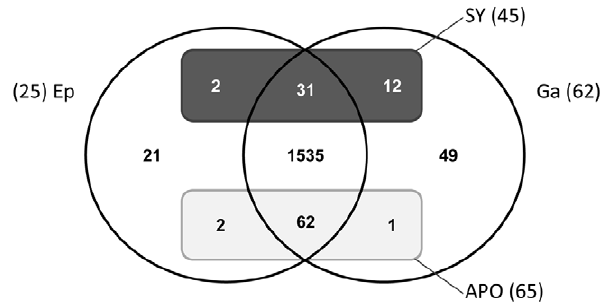
Figure 4. Venn diagram of genes expressed in sea anemone tissues. Distribution of genes (only of cnidarian origin) expressed in the epidermis (Ep) or gastroderm (Ga) compartments (circles), relative to their up-regulation (rectangles) in symbiotic (SY) or aposymbiotic (APO) conditions.